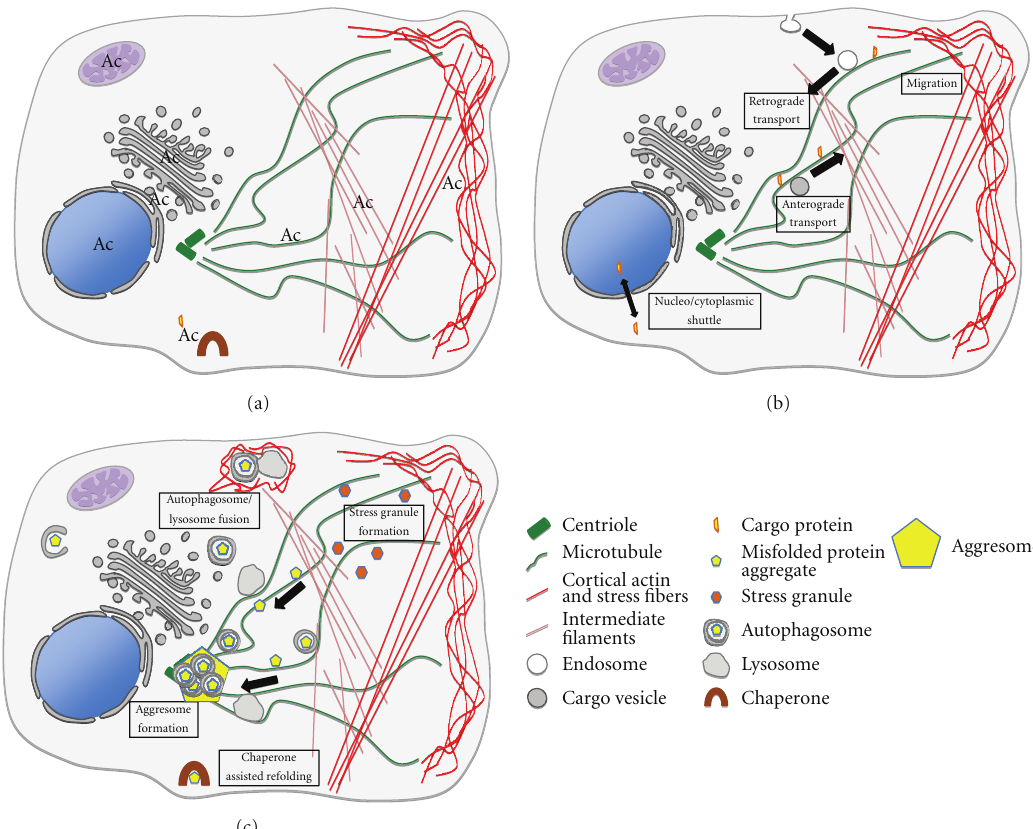
Figure 1: Schematic overview of cytoplasmic mechanisms regulated by acetylation. (a) Localisation of acetylation events within a cell. Indicated are individual acetylated proteins and cytoskeletal structures (cortical actin and actin stress fibers, microtubules, intermediate filaments) as well as organelles (nucleus, mitochondria, ER, ERGIC, golgi) in which acetylation and deacetylation events take place. (b) Involvement of reversible acetylation in the regulation of various cytoplasmic processes, including cell migration following cytoskeleton remodelling, individual protein transport as well as vesicular transport and nucleocytoplasmic shuttling of proteins. (c) Regulation of stress response and cytoplasmic cleanup systems by various acetylation/deacetylation